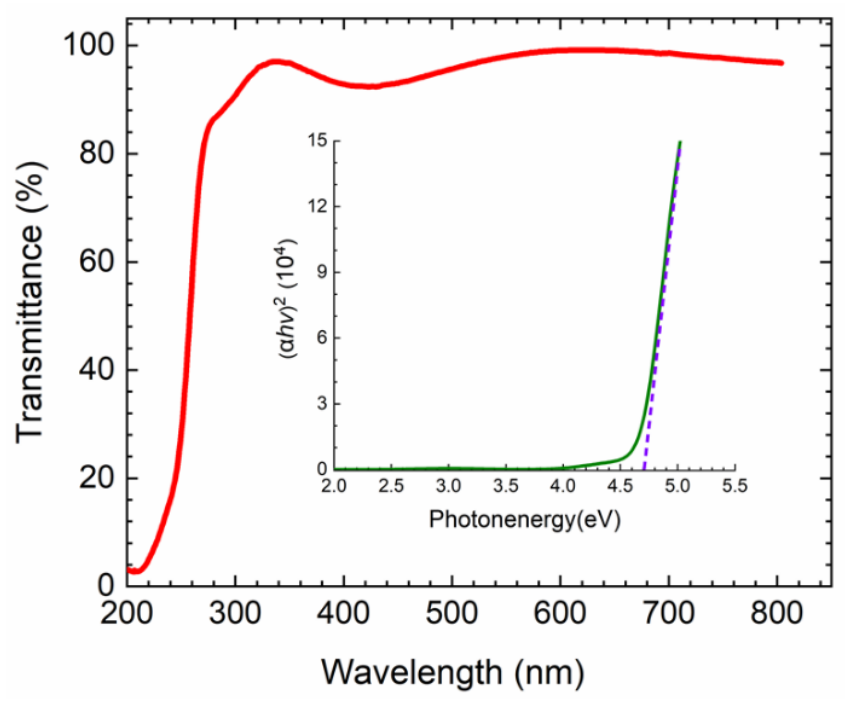
Figure 6. Optical transmission spectrum of the β -Ga 2 O 3 nanowires. ( α h υ ) 2 versus photon energy plots of the β -Ga 2 O 3 nanowires in the inset.